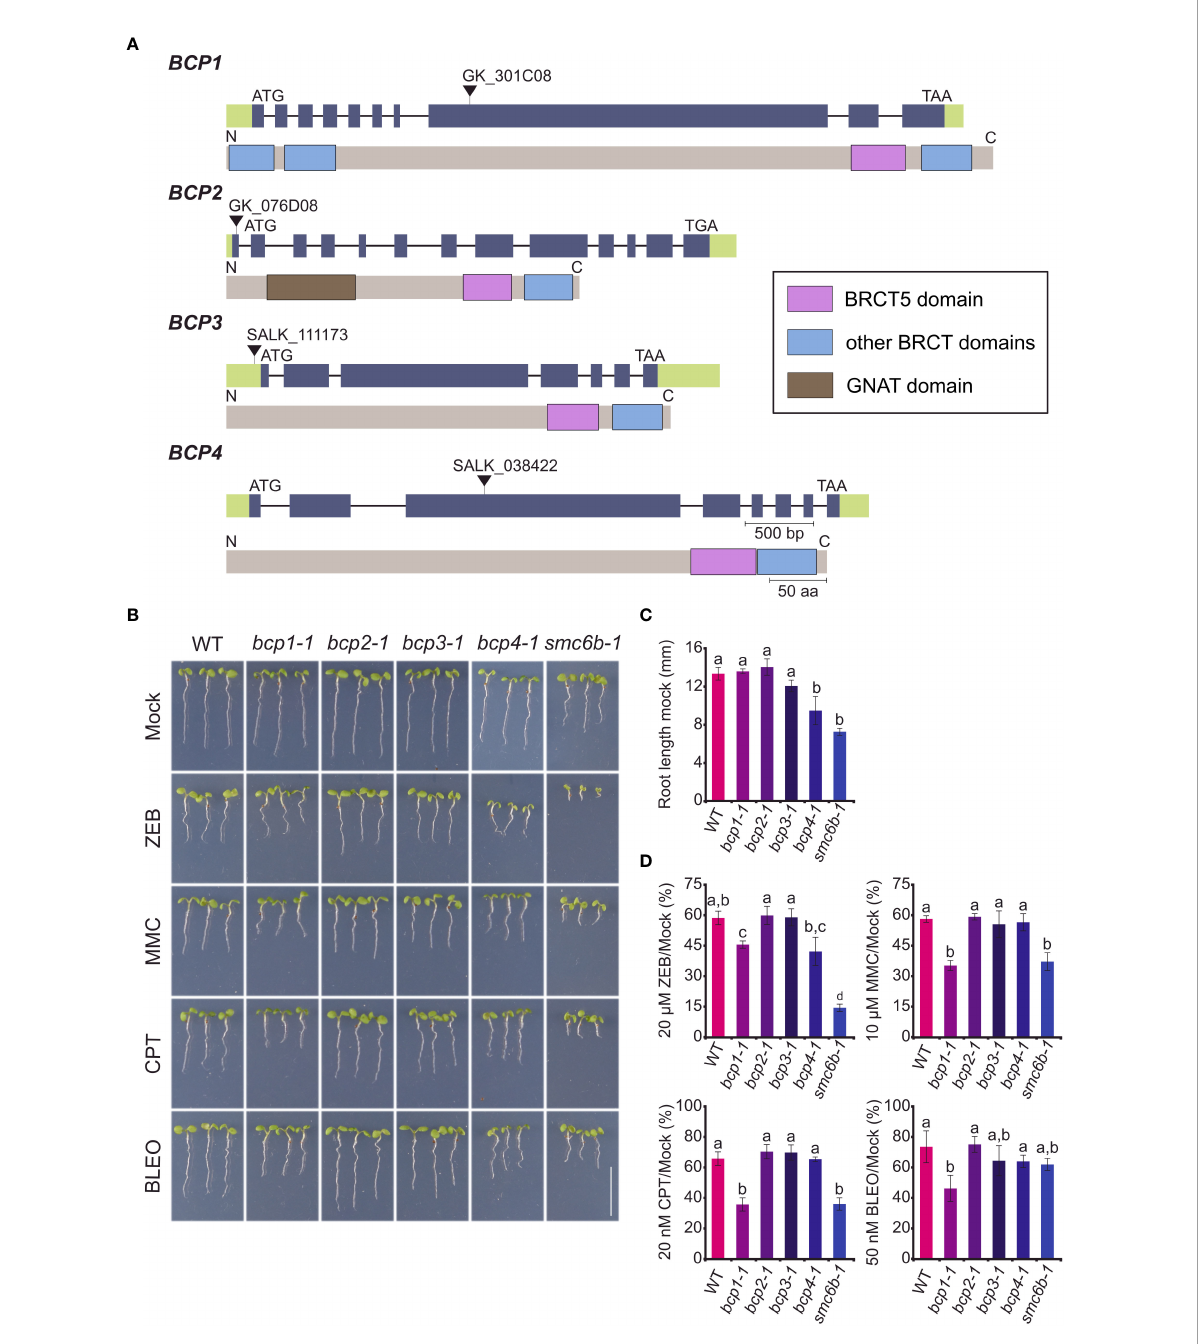
FIGURE 2 Phenotypes of mutants in uncharacterized Arabidopsis BRCT5 domain-containing genes. (A) Gene and protein structures of the BRCT5 CONTAINING PROTEINS (BCPs). The positions of T-DNAs in the used mutant alleles are indicated by black triangles above the gene models. Introns are indicated by a horizontal line and exons by green (untranslated regions) and purple (coding sequence) colors. Protein models under gene models (grey) show the position of known domains: BRCT - blue rectangles and GNAT (Gcn5-related N-acetyltransferase) - brown rectangle. (B) Representative phenotypes of seven days old wild-type (WT) and homozygous mutant plants grown on media containing 20 m M zebularine (ZEB), 10 m M mitomycin C (MMC), 20 nM camptothecin (CPT), 50nM nM bleocin (BLEO). The smc6b-1 served as a sensitive control. Scale bar = 1 cm. (C) Root length of WT and mutant plants under control (mock) conditions. Error bars indicate the standard deviation between the means of three biological replicates. The letters above columns indicate similarities between samples. The same letters indicate samples that were not signi fi cantly different in one-way ANOVA with post hoc Tukey ’ s test ( P < 0.05). (D) Root length of WT and mutants from B under DNA damaging treatments relative to the growth of the same genotype under mock conditions. Error bars represent the standard deviation between three biological replicates, each with at least 15 plants. Statistics were performed as in (C)